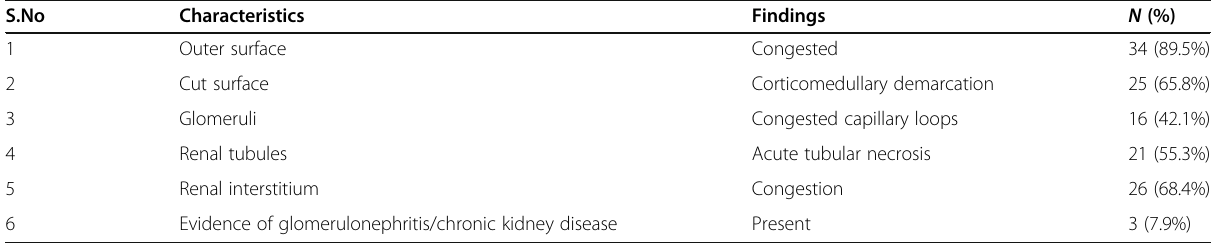
Table 1 Findings of kidneys